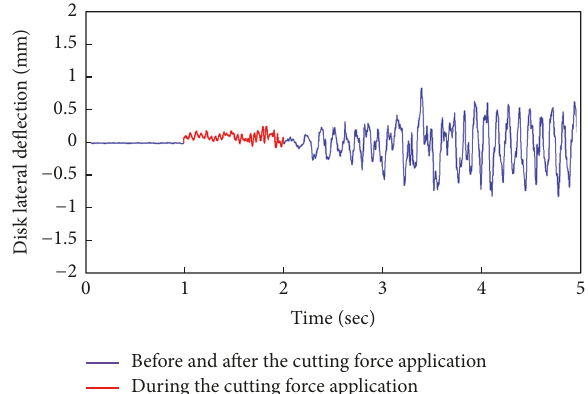
Figure 16: FEM results, disk lateral deflection at position of outer radius, angle 90 ∘ , subjected to cutting forces, at rotation speed 1800 rpm.